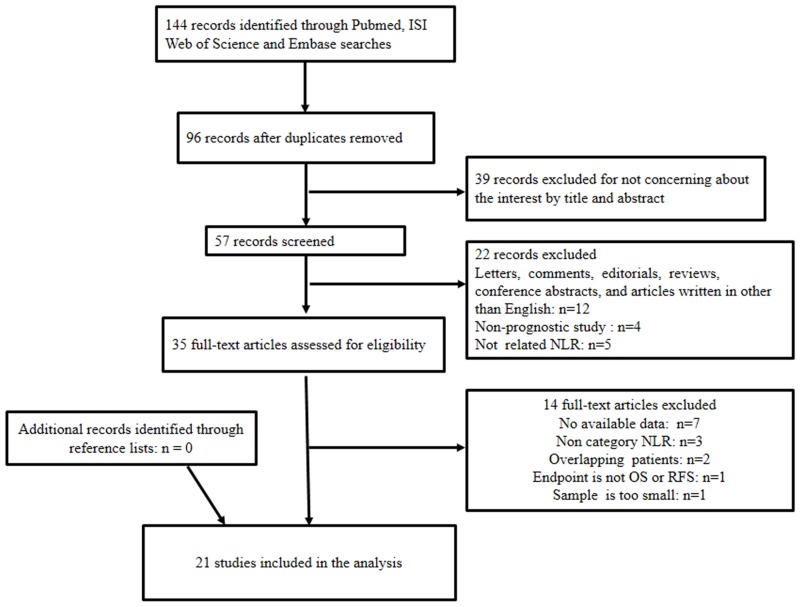
Flowchart of selection of studies for inclusion in meta-analysis.